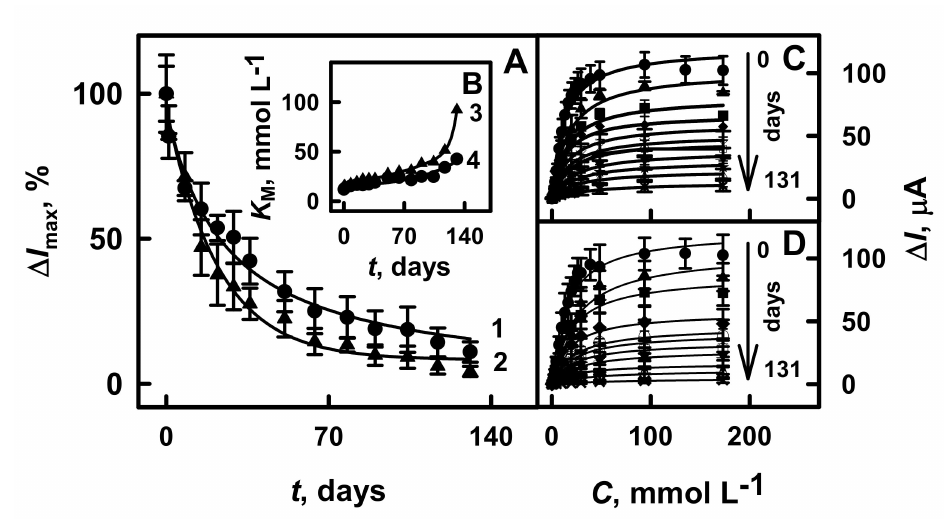
Figure 6. The changes of analytical signal ( A ), and the increase of the apparent Michaelis constant over time ( B ), calibra- tion plots of glucose biosensors based on GR/PANI-AuNPs (6 nm) -GOx/GOx electrode ( C ) and on GR/Ppy-AuNPs (6 nm) - GOx/GOx electrode ( D ). Details of the presented calibration plots: GR/PANI-AuNPs (6 nm) -GOx/GOx electrode (( A ) line 1, ( B ) line 4, and ( C ) all lines) and GR/Ppy-AuNPs (6 nm) -GOx/GOx electrode (( A ) line 2, ( B ) line 3 and ( D ) all lines). Amperometric responses were registered in 0.05 mol L − 1 SA buffer, pH 6.0, with 0.01 mol L − 1 KCl and 6.0 mmol L − 1